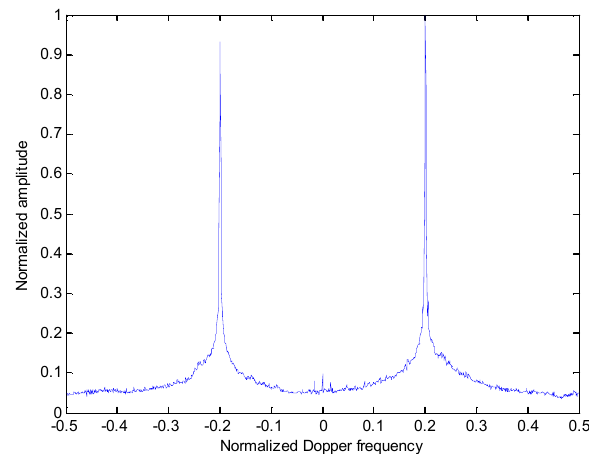
Figure 5. Maximization projection onto the Doppler frequency dimension.